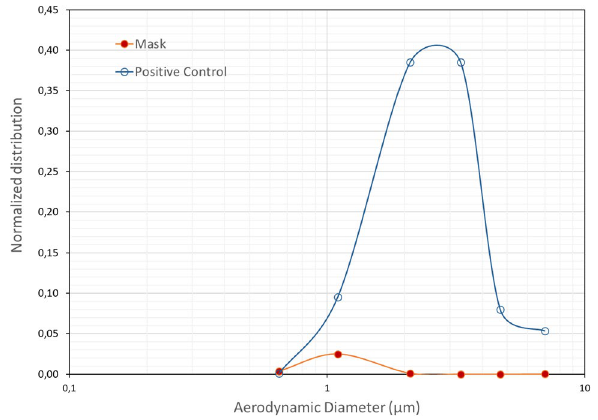
Figure 5. Normalized distribution of the S. aureus aerosol for positive control and the Mask A tests calculated as the ratio between the number of particles per stage and the total number of particles for the positive control